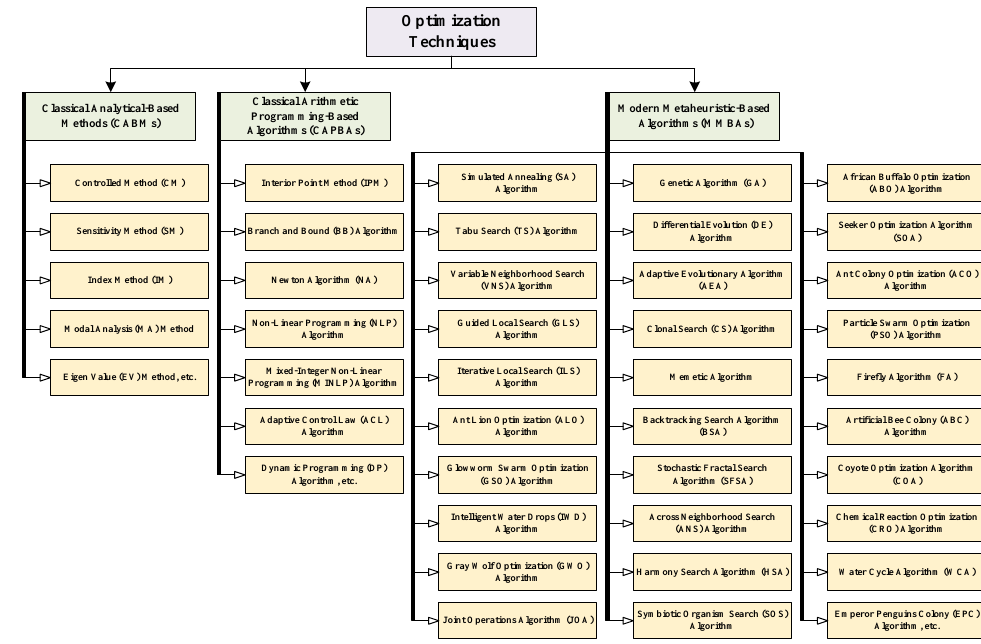
Figure 2. Classification of optimization